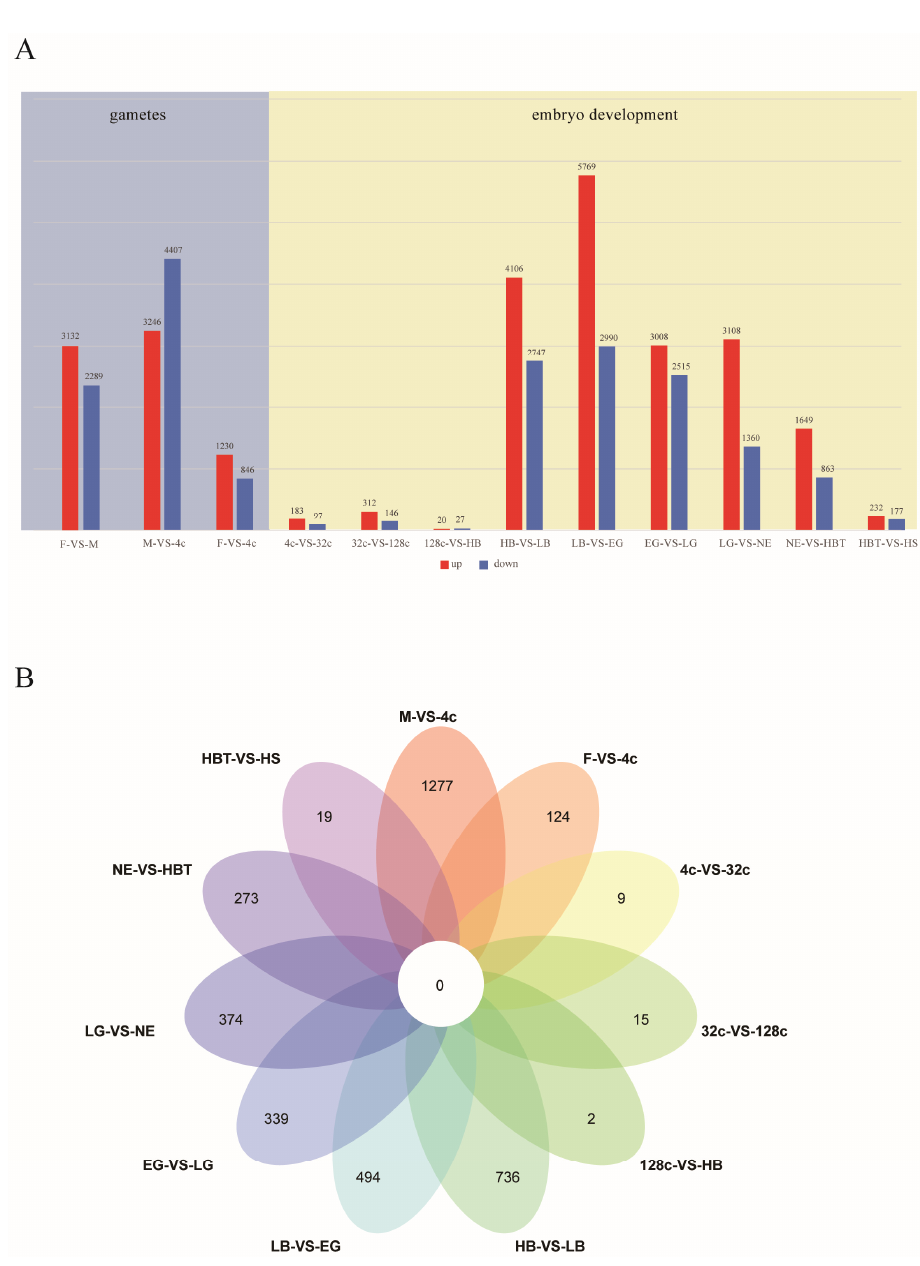
Figure 2. The dynamic expression profile of embryo developmental stages in Japanese flounder. ( A ) The number of differentially expressed genes (DEGs) identified between two adjacent developmen- tal stages; Red and blue colors indicate up-regulated and down-regulated genes at later stage vs. early stage; ( B ) Venn diagram depicts the stage-specific DEGs. M: sperm, F: egg, 4c: 4-cell, 32c: 32- cell, 128c: 128-cell, HB: high blastula, LB: low blastula, EG: early gastrula, LG: late gastrula, NE: neurula, HBT: heart-beating, HS: hatching stage.